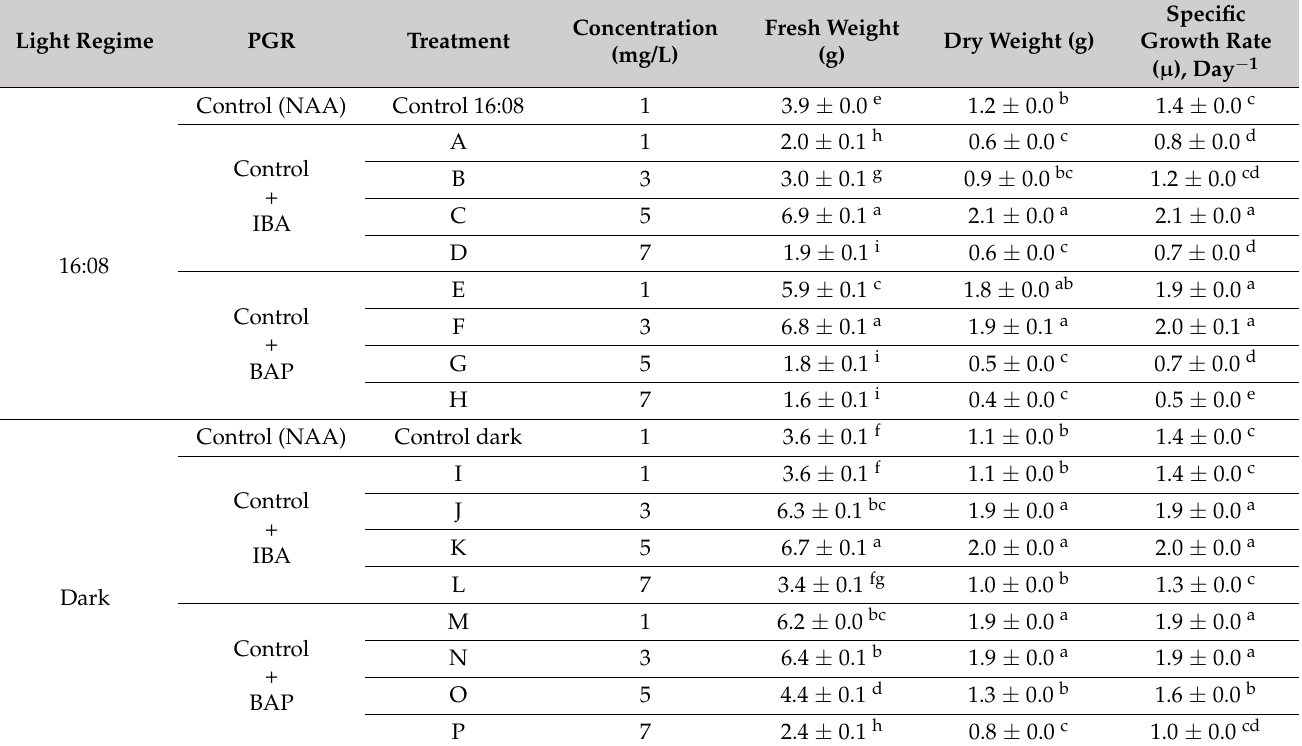
Table 2. Combined effects of auxin–auxin and auxin–cytokinin on adventitious root growth of Z. zerumbet in 16:08 photoperiod and dark condition.